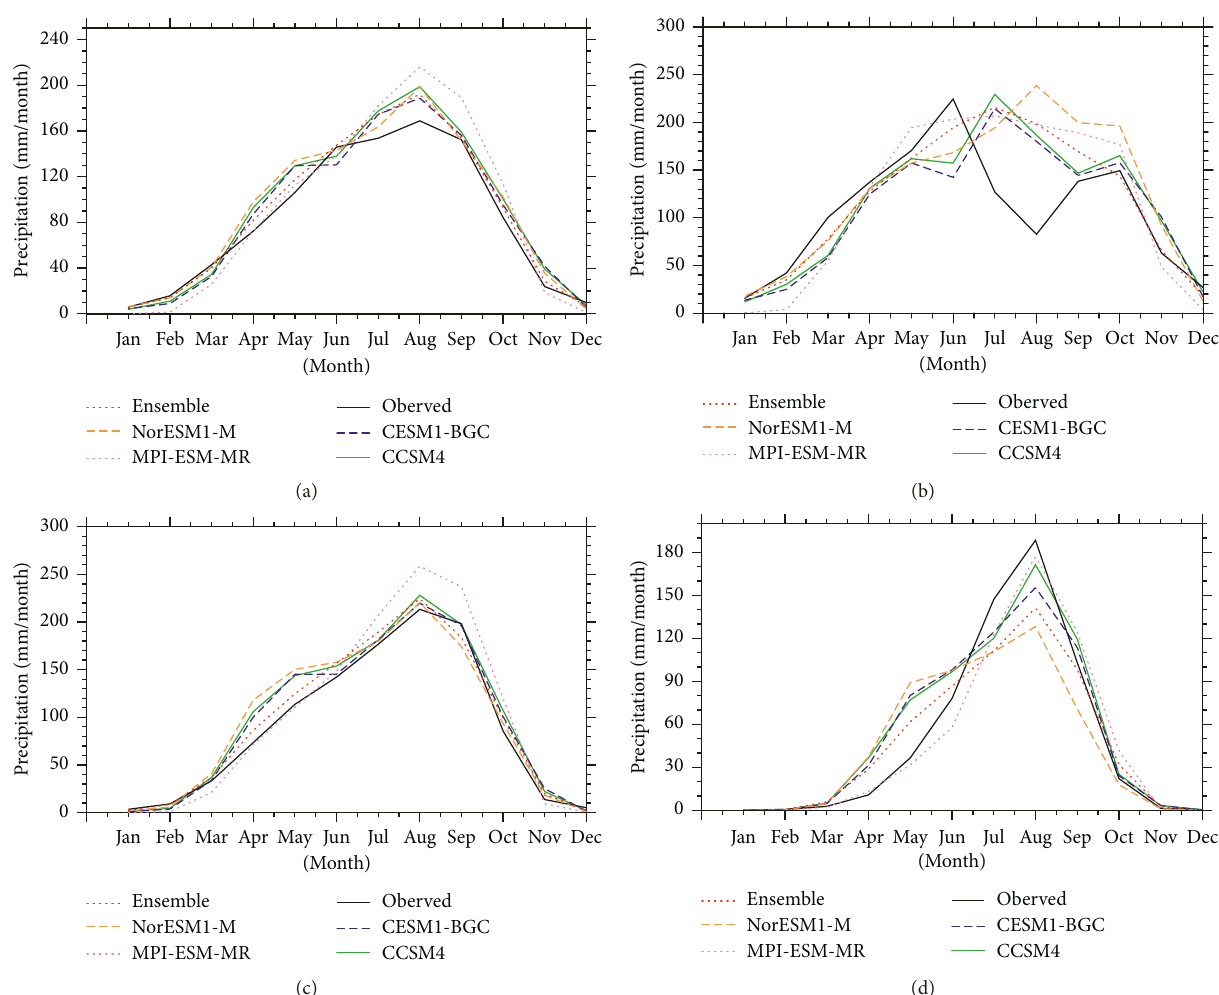
Figure 8: Annual cycles of monthly total precipitation for the period mean showing the bimodal (over the GC (b)) and the unimodal patterns (over the VB (a), the SD (c), and the SA